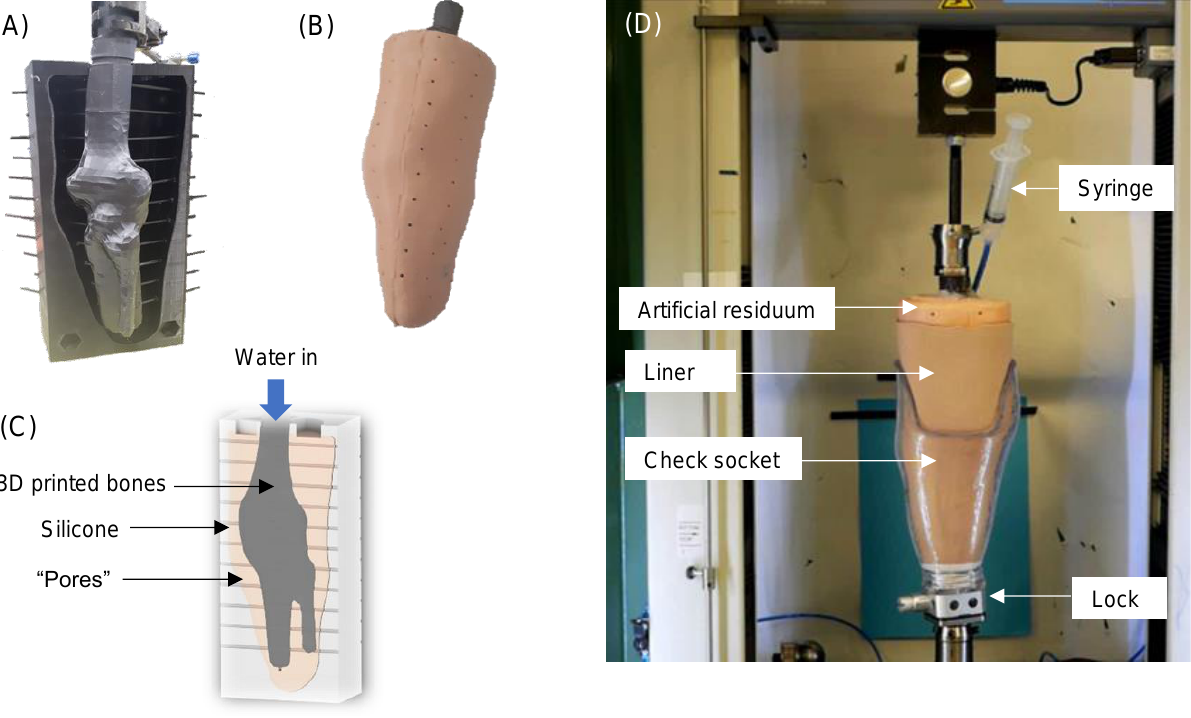
Figure 1: ( A ) The 3D printed bones held in place in the negative residuum mould with 3mm straws to create “pores” ( B ) the moulded silicone artificial residuum with pores visible along its surface ( C ) an annotated cross-section diagram of the artificial residuum ( D ) the artificial residuum set up on the test